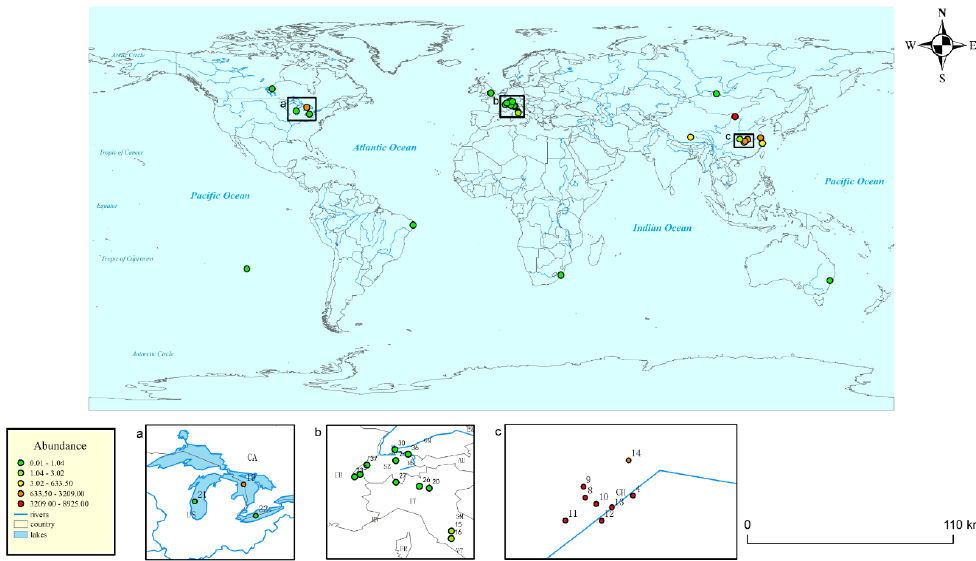
Figure 1. The distribution of microplastics in typical freshwater bodies around the world.